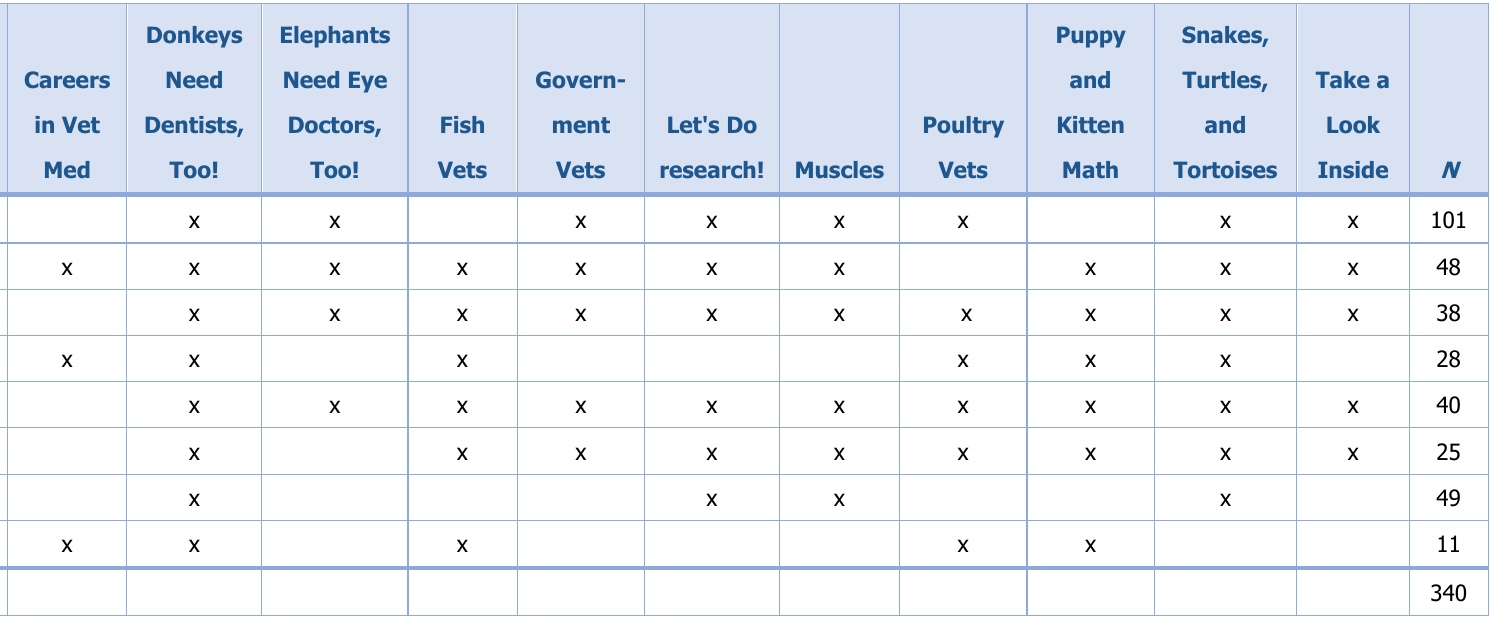
Note. N = Number of youth who took the pre- and post-program